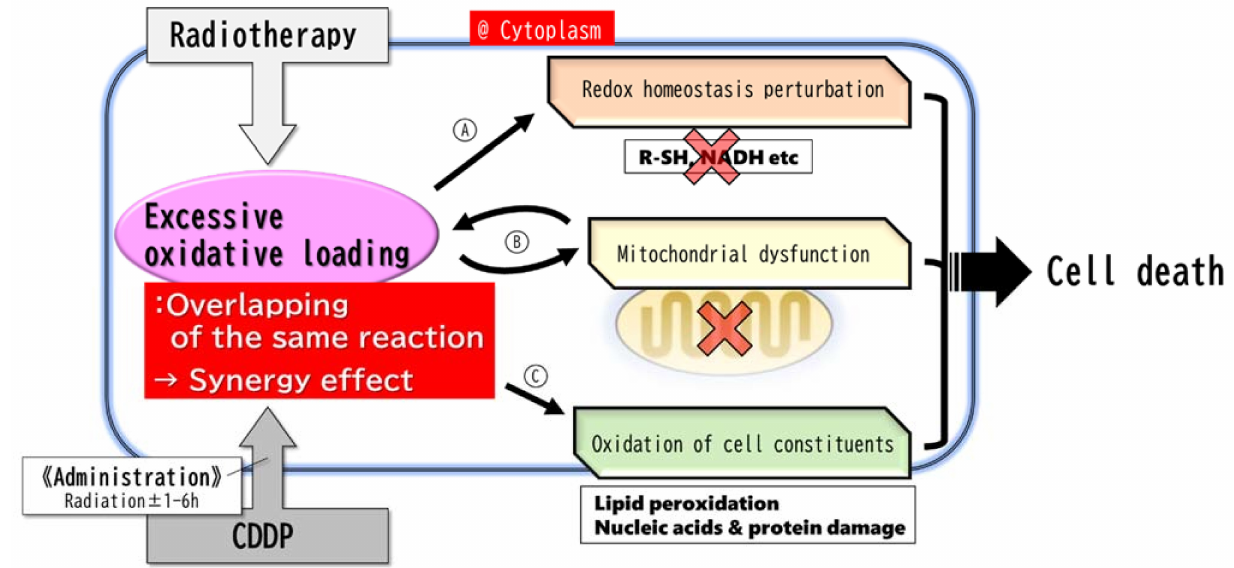
Figure 1. Major reaction. The major reaction occurs mainly in the cytoplasm. Radiation and CDDP give cells an identical excessive oxidative loading response, resulting in a synergistic effect leading to cell death. The metabolic response to the excessive oxidative loading by CDDP reaches its maximum within 6 h and is rapidly resolved thereafter. Therefore, it is necessary to administer CDDP within 6 h before or after radiation in order to obtain the synergistic effect. ( A ) Radical scavengers and NADH/NAD+ rate decrease → redox homeostasis perturbation → metabolic (Warburg effect, DNA repair, etc.) malfunctions. ( B ) Mitochondrial dysfunctions → more excessive and persistent oxidative stress, and apoptosis. ( C ) Oxidation of cell constituents (especially lipid peroxidation) → cell dysfunctions, destruction of cell components (DNA, etc.),